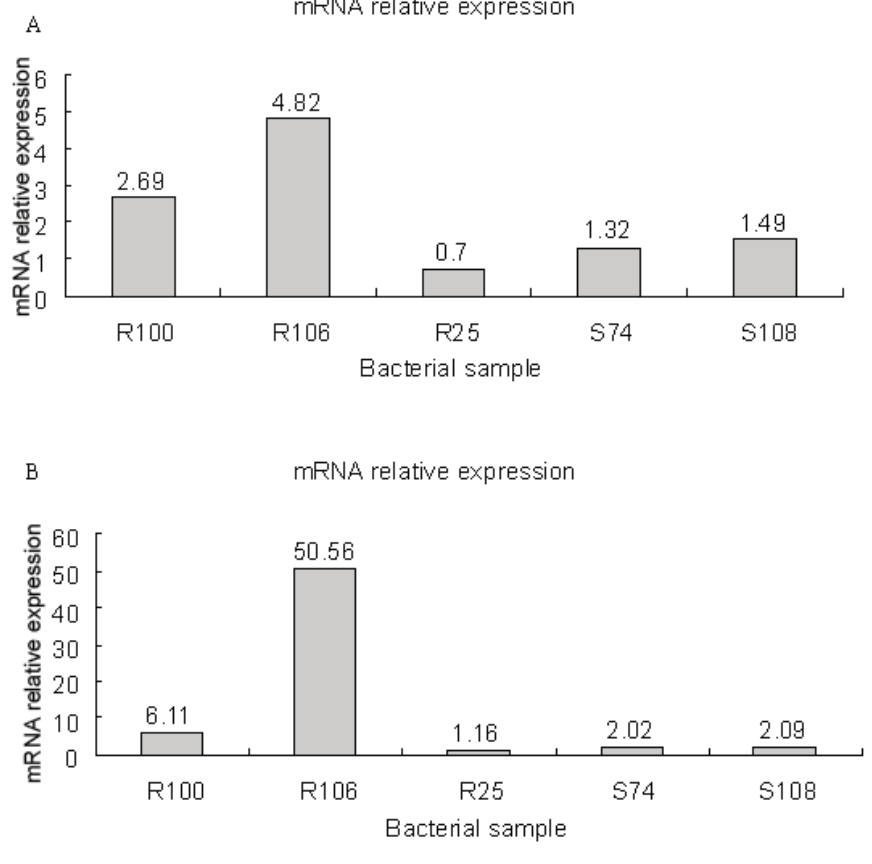
Figure 1. Relative mRNA expression of smeD ( A ) and smeF ( B )